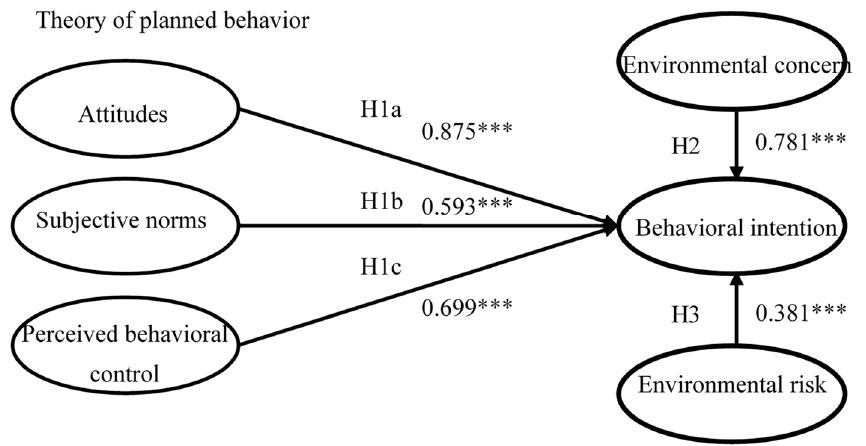
Figure 2. Path analysis of the hypothesis model. GFI = 0.926; CFI = 0.917; NFI = 0.943; TLI = 0.956; AGFI = 0.913; and RMSEA = 0.017. Note: *** p < 0.001; solid lines denote established hypotheses. The result of the analysis is positive indicate that there is a positive relationship between variables.